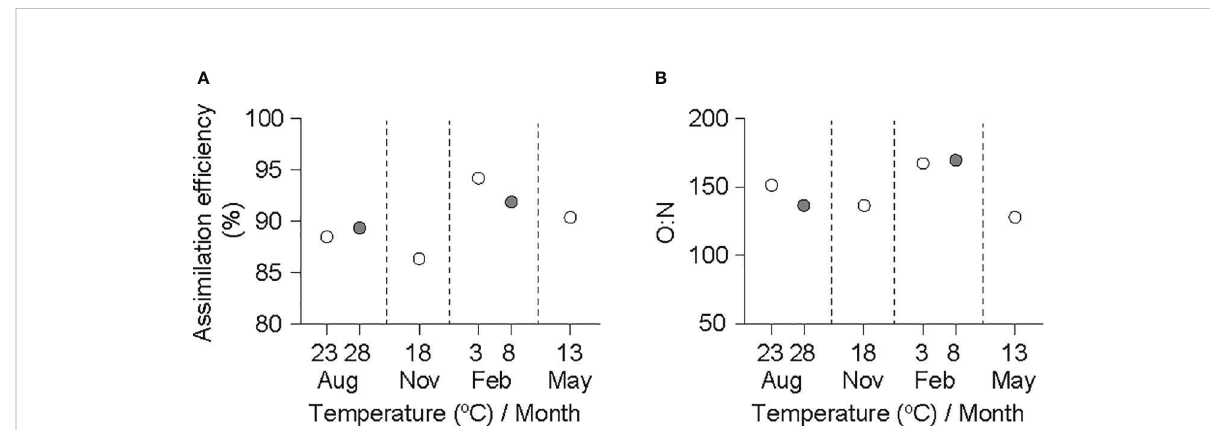
FIGURE 4 Assimilation ef fi ciency (A) and O:N ratio (B) in an individual ark shell ( Anadara kagoshimensis ) with a dry- fl esh weight of 0.6 g recorded in all six experimental groups in August and November 2017, and February and May 2018. The open and closed circles of August and February represent cold and warm conditions in summer and winter,